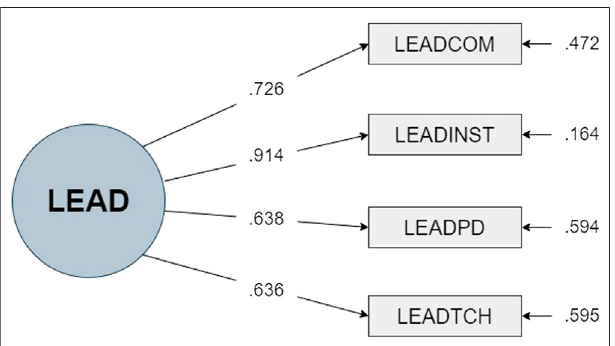
FIGURE 2 | Initial measurement model of four forms of principal leadership. Note: All displayed values signi fi cant at p ≤ 0.05.